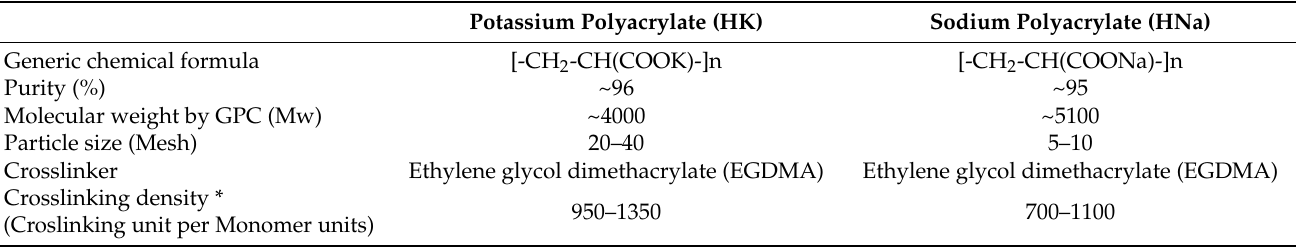
Table 1. Main characteristics of the commercial hydrogels.